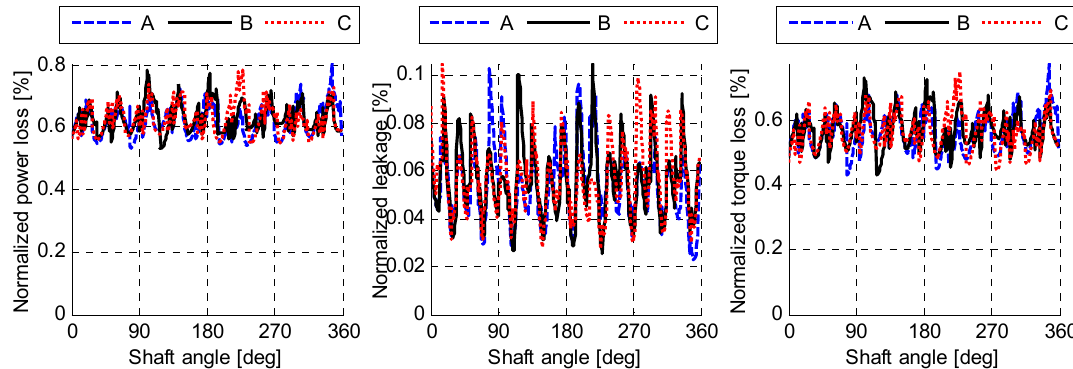
Figure 11. Normalized cylinder block/valve plate interface performance comparison for different sizes.